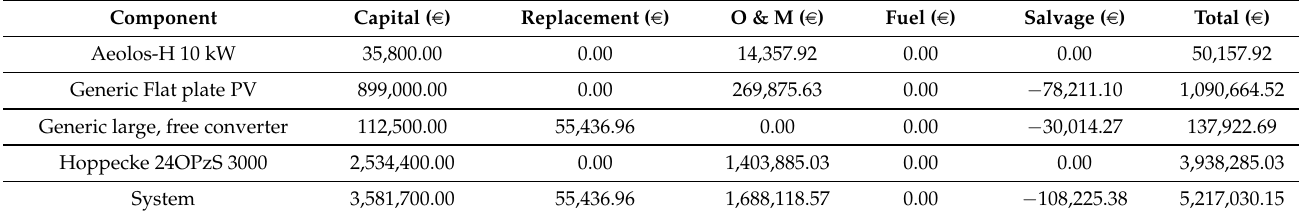
Table 32. Analytical costs of each component Case 2 Scenario